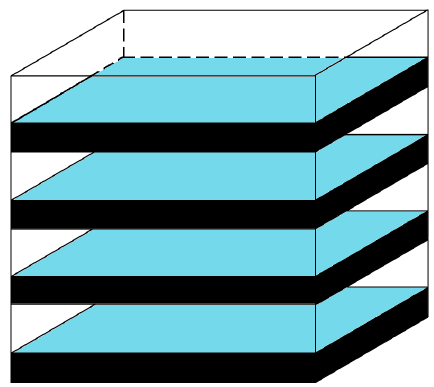
Figure 6. Schematic diagram of the carbon capture apparatus.